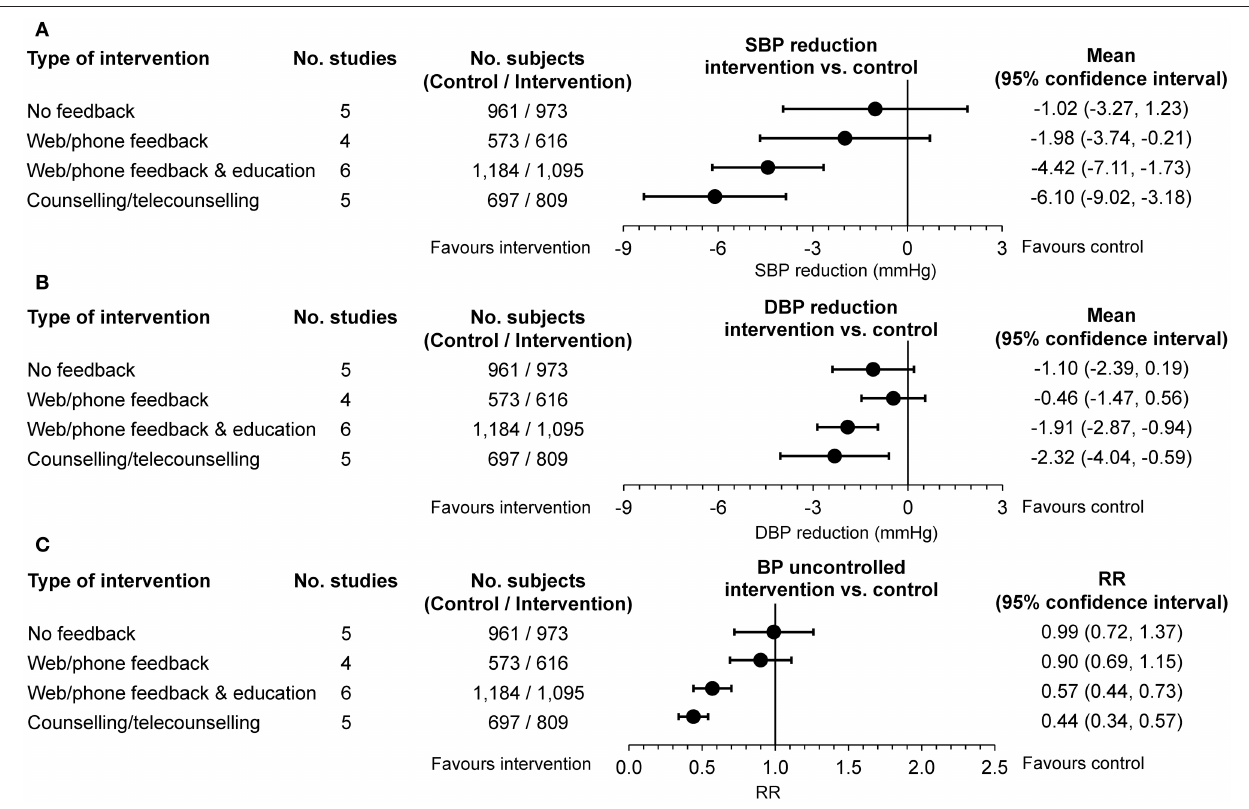
FIGURE 2 | (A) Changes in office systolic blood pressure (SBP) and (B) diastolic blood pressure (DBP) and (C) rates of poor office blood pressure (BP) control at 12 months (intervention vs. usual care serving as control). Data are adjusted for age, sex, baseline clinic BP, and history of diabetes. Differences are shown as mean or relative risk (RR) and 95% confidence interval according to four levels of intervention (self-monitoring of BP with no feedback, self-monitoring with web or phone feedback, self-monitoring with web, or phone feedback and education, self-monitoring with counseling or telecounseling) [from (26) by